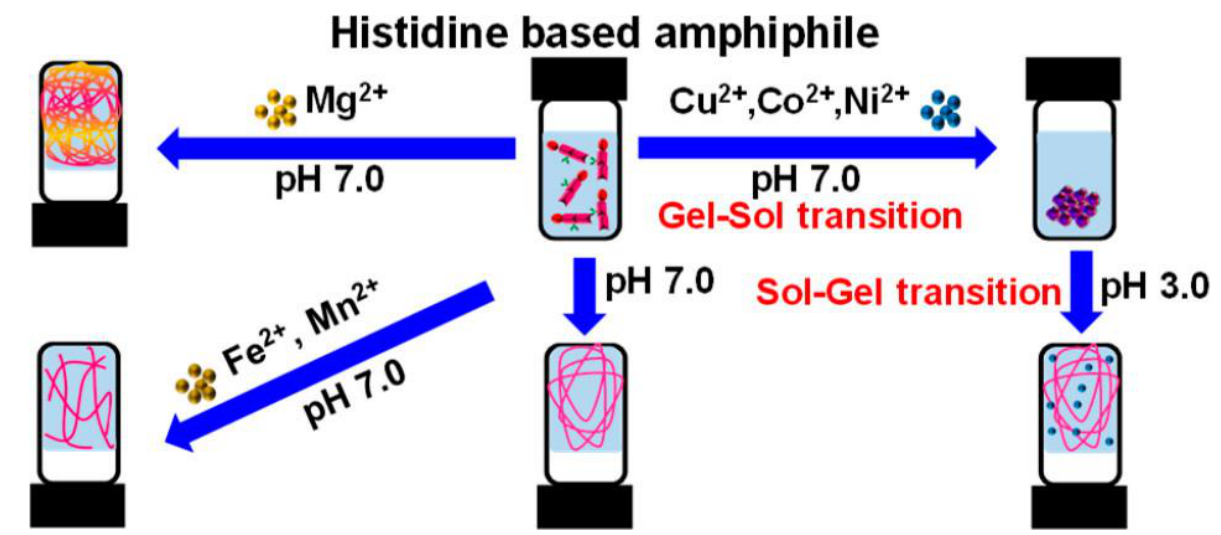
Figure 6. Metal-cation responsive behavior of supramolecular hydrogels composed of Fmoc-dipeptides with His. Reproduced with permission from [51]. Copyright © 2019, American Chemical